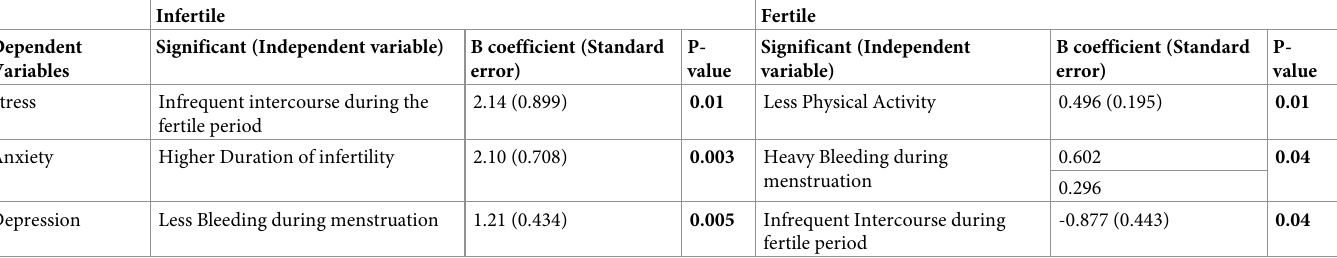
Table 6. Linear regression with respect to statistically significant demographic, lifestyle, and reproductive trajectories among infertile and fertile women.